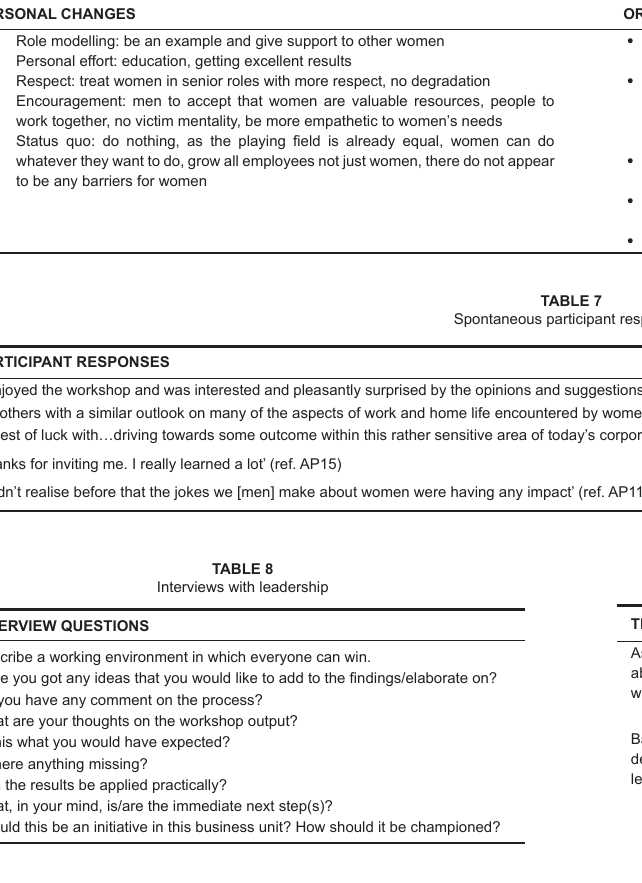
TABLE 6 Destiny stage: personal and organisational changes